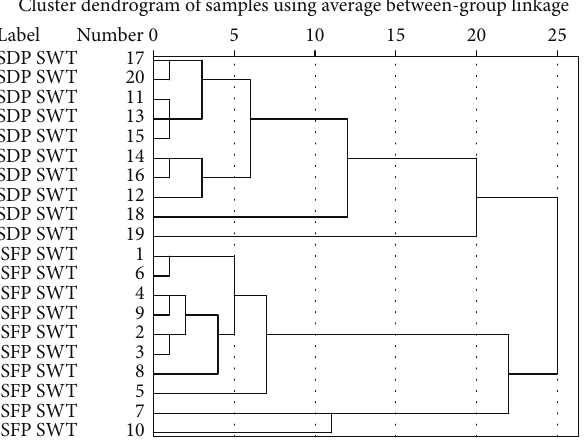
Figure 2: Hierarchical clustering dendrogram of twenty batches of SWT (1–10, SFP SWT; 11–20, SDP